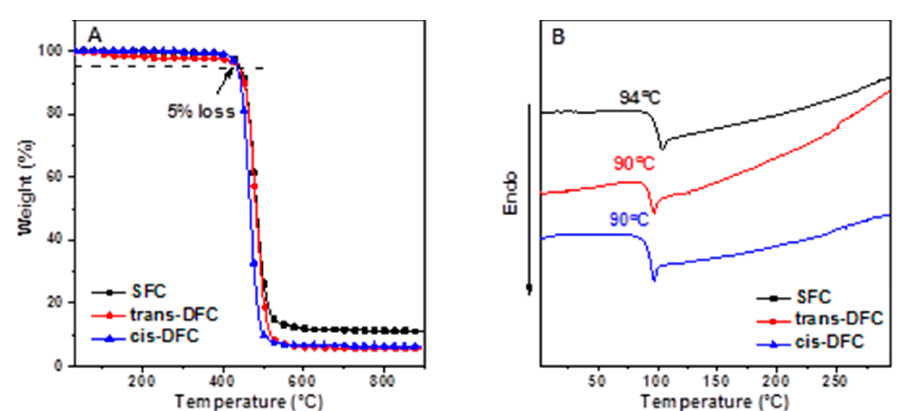
Figure 1. Thermogravimetric analysis (TGA) ( A ) anddifferential scanning calorimetry (DSC) ( B ) graphs of SFC, trans -DFC and cis -DFC.